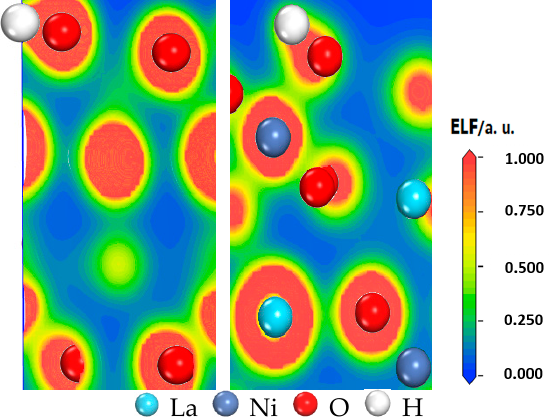
Figure 4. Electron localization function of LaNiO 3 (001)/H 2 on B3 after geometry optimization of the structure.